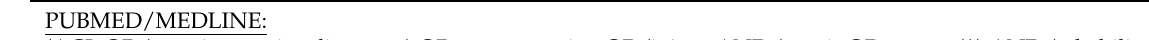
Table A1. Databases search